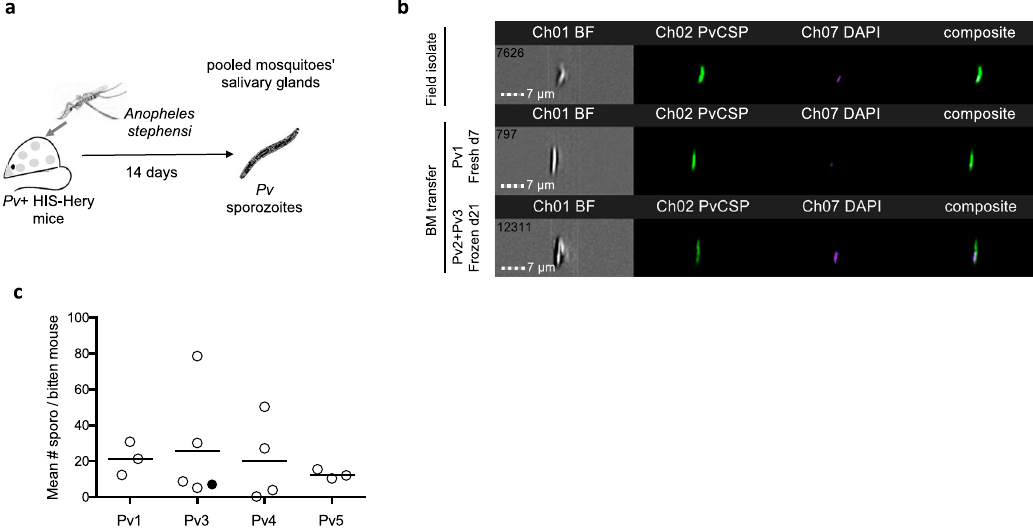
Fig. 4 HIS-HEry chimeras support P. vivax sexual differentiation, gametocyte transmission to Anopheles , and sporozoite formation. a Individual HIS- HEry infected chimeras were bitten by Anopheles stephensi mosquitoes, and sporozoite production in pooled mosquito salivary glands was assessed 14 days later. b Representative FlowFISH ImageStream pro fi les of salivary gland sporozoites, stained with a fl uorescent marker for P. vivax circumsporozoite protein (PvCSP, green ; Chanel 2 for FITC) and DAPI to visualize nuclei (Chanel 7). The composite images (right column) show colocalization of nuclei and surface PvCSP. The different samples are from: ( upper row ) frozen patient fi eld blood isolates, ( middle row ) mosquitoes that fed on day-7 Pv1-infected HIS-HEry mice, and ( bottom row ) mosquitoes that fed on day-7 HIS-HEry mice infected with frozen BM isolated from day-21-infected mice (see Fig. 2b). c Plots show the mean numbers of sporozoites obtained per mosquito fed on individual mice(sporo; calculated as the total sporozoites isolated from all mosquitoes that bit each individual mouse/the total number of mosquitoes that bit that individual mouse — see Supplementary Fig. 3b), for each group of mice infected with the indicated Pv isolates. The fi lled dot in the Pv3 column indicates that this mouse was infected with a pool of Pv2 + Pv3. Each dot represents one individual mouse. n = 15 individual mice dispatched according the isolates used to infect. Means ± SD are: Pv1 = 21.2±9.24; Pv3 = 31.1±23.2; Pv4 = 20.12±23.21; Pv4 = 12.37±2.59. Source data are provided as a Source Data fi